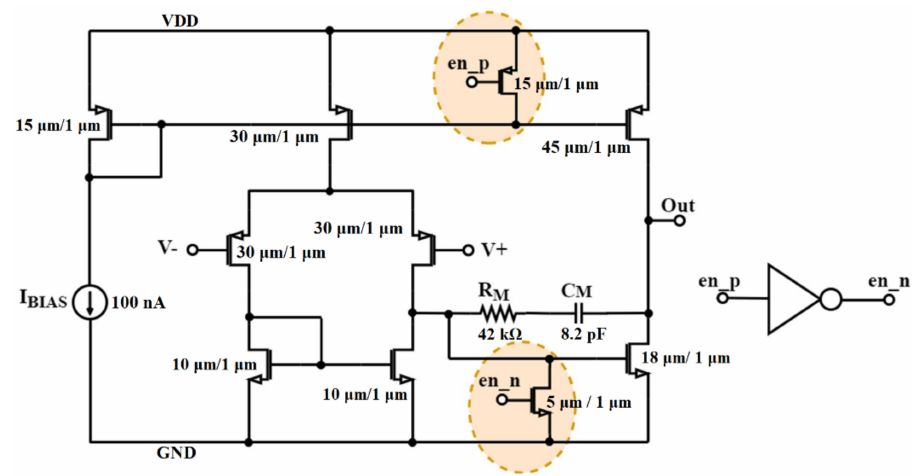
Figure 13. Schematic of op-amp with enable feature.